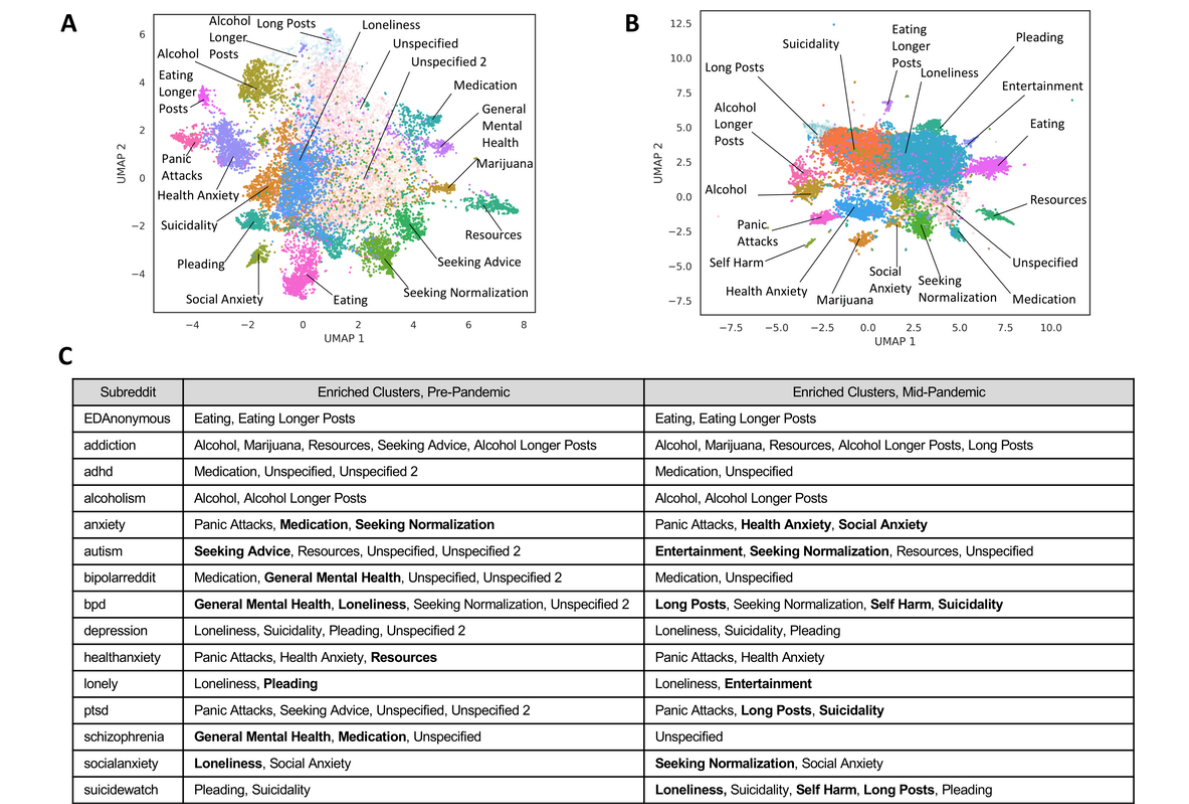
Figure 3. Unsupervised clustering reveals post groupings with representation across mental health subreddits. A) Unsupervised clustering of pre-pandemic (year 2019) posts from 15 mental health subreddits, presented in 2D UMAP space. Posts in two thematically-related, adjacent clusters were collapsed into a single “Resources” cluster. Three clusters could not be assigned identifiable themes. Two of these—annotated as ”Unspecified”—were the largest clusters in the dataset, containing 6329 and 4272 total posts, respectively, while the next largest cluster contained 1620 posts. The other cluster